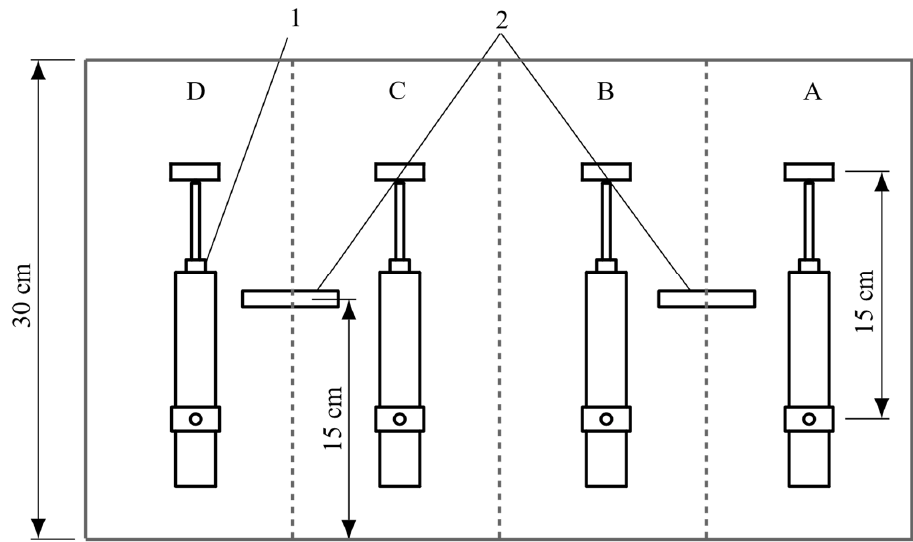
Figure 2. Specimen surface development: 1. LDT devices; 2. SG sensors; A, B, C and D–sectors (ac- cording to Figure 1). (according to Figure